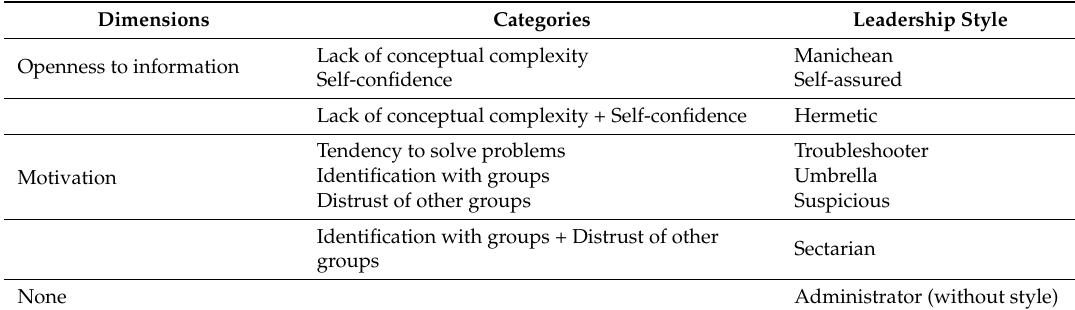
Table 1. Dimensions, categories and leadership